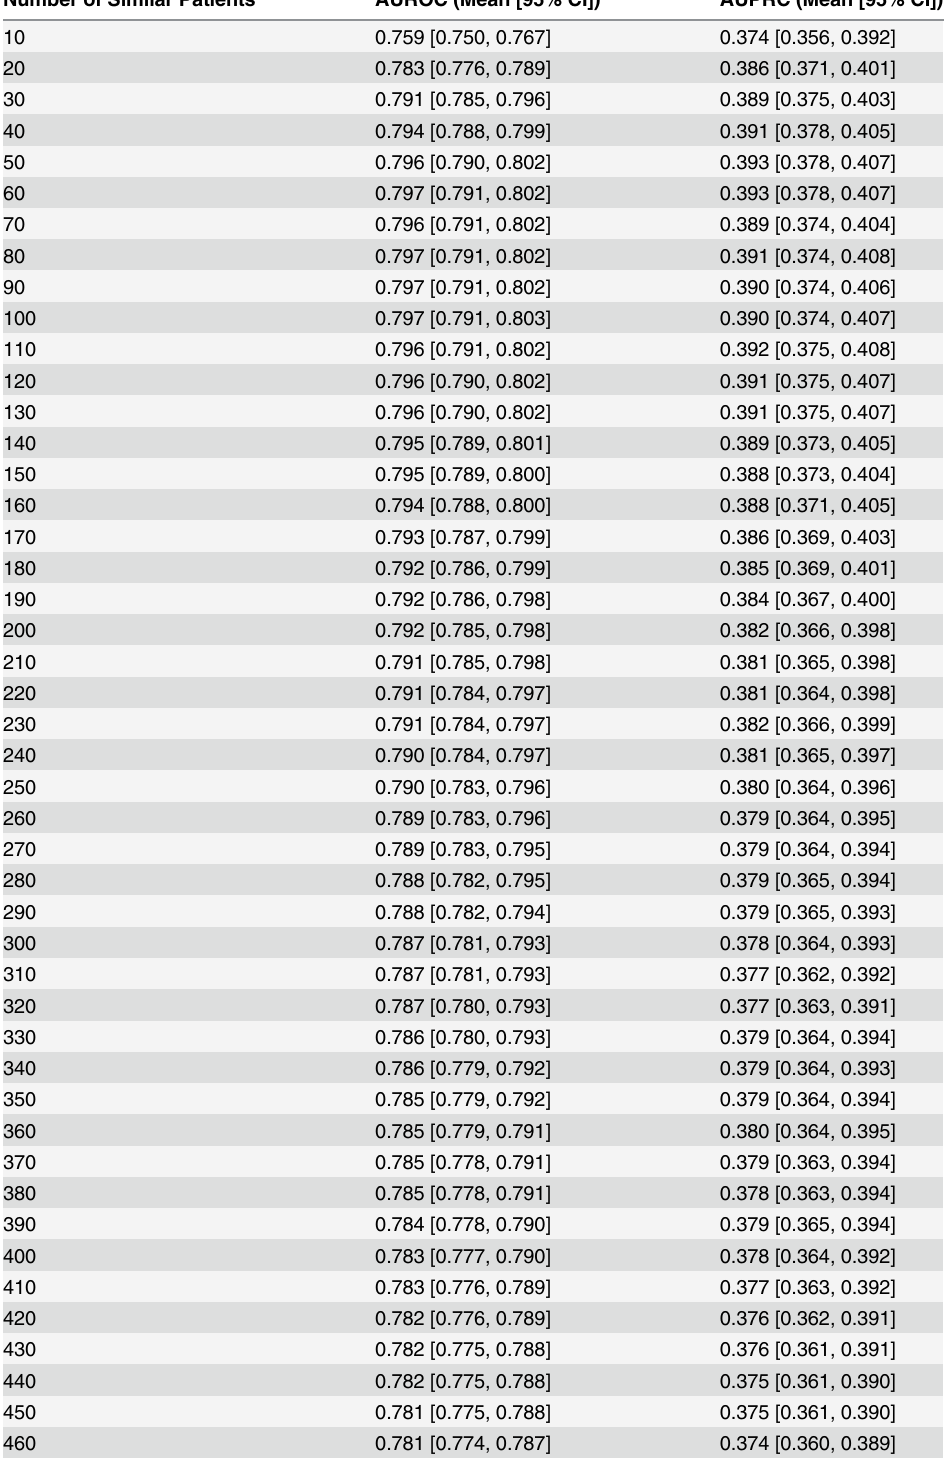
Table 2. Mortality prediction performance of death counting as a function of the number of similar pa- tients used in